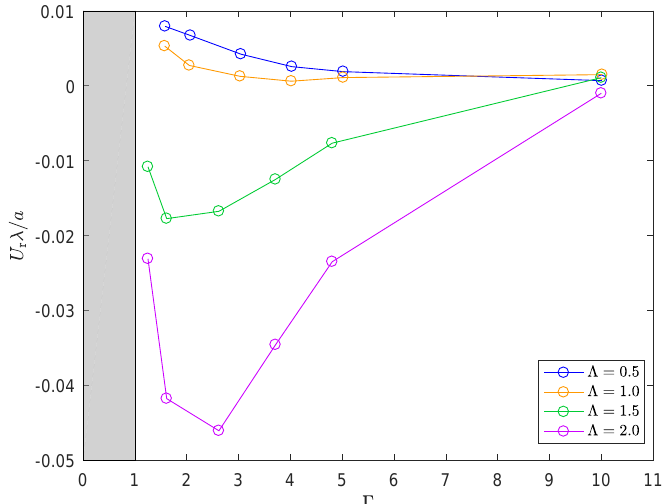
Figure 4. Migration velocity of the particle at different positions from the inner cylinder without shear and varying sedimentation Weissenberg number at time t / λ = 10. The shaded area indicates the inaccessible